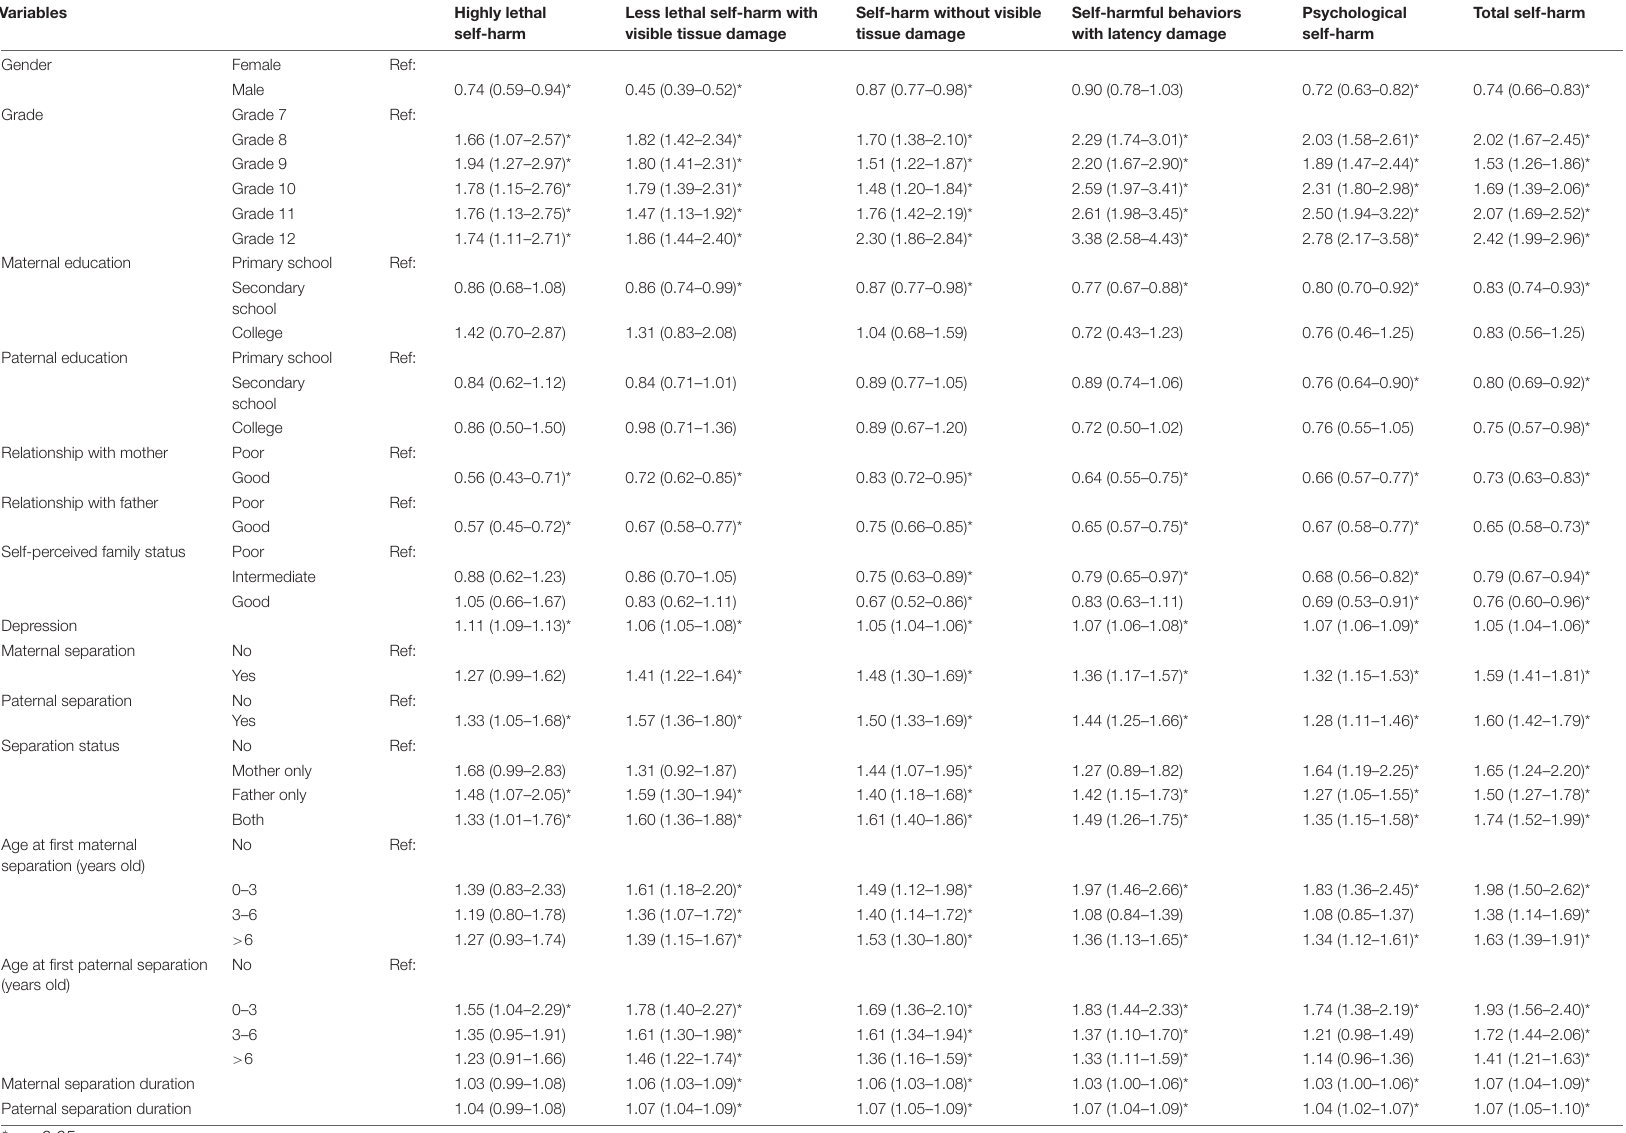
TABLE 2 | Unadjusted OR (95% CI) for self-harm by univariate analysis ( N = 4,928).